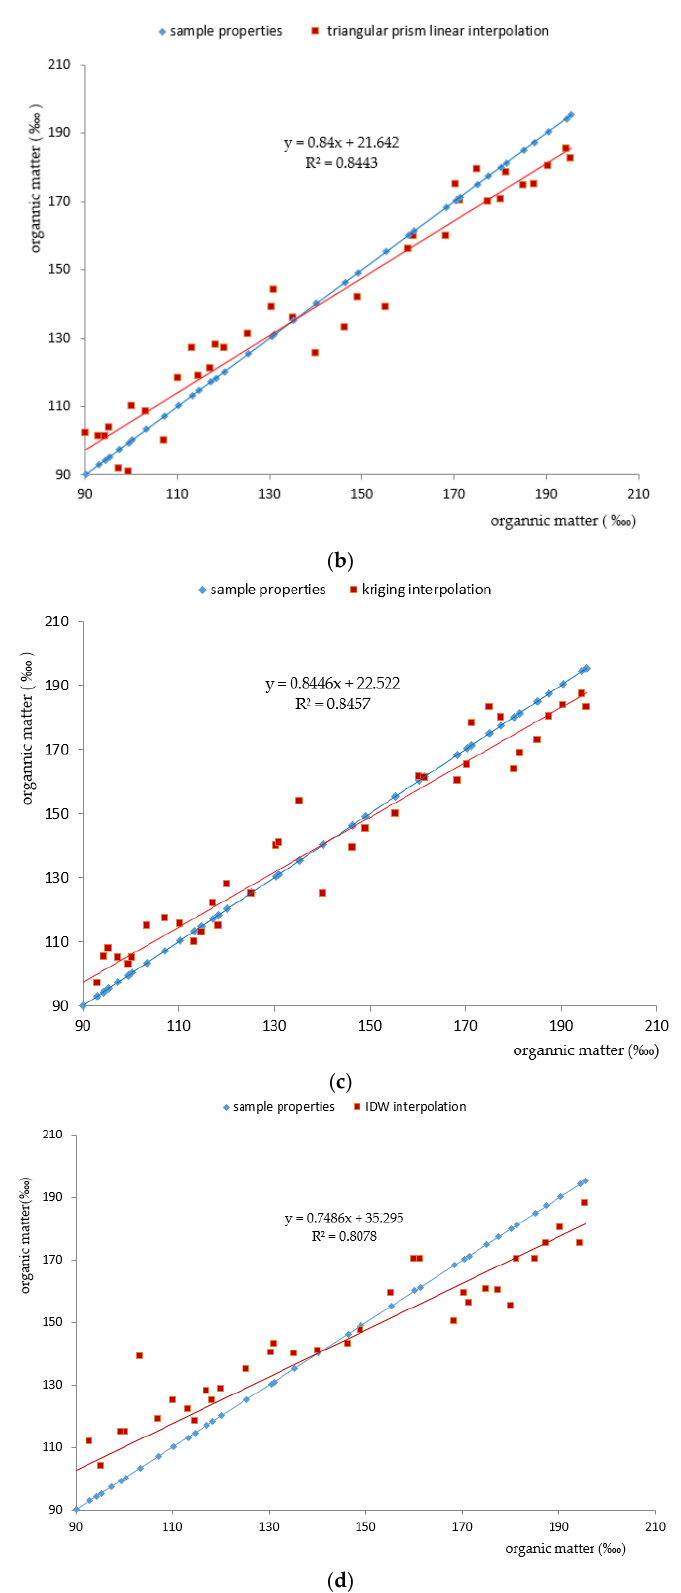
Figure 14. Cross-validation of the interpolation results. ( a ) Cross-validation of triangular prism quadric interpolation; ( b ) cross-validation of triangular prism linear interpolation; ( c ) cross-validation of kriging interpolation; ( d ) cross-validation of IDW interpolation.